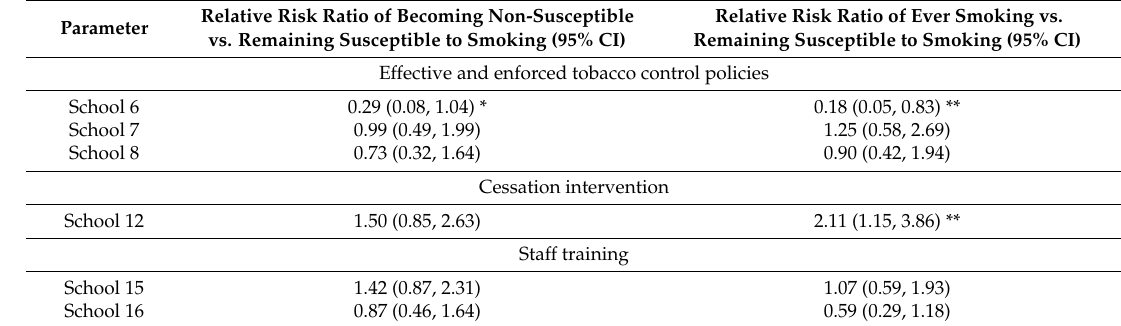
Table 3. Multinomial logistic regression analyses (Model 2) evaluating the impact of six school-specific tobacco interventions implemented between baseline and follow-up among baseline susceptible never smokers, 2012–2014 COMPASS study, Ontario, ON, Canada. Relative Risk Ratio of Ever Smoking vs. Remaining Susceptible to Smoking (95%